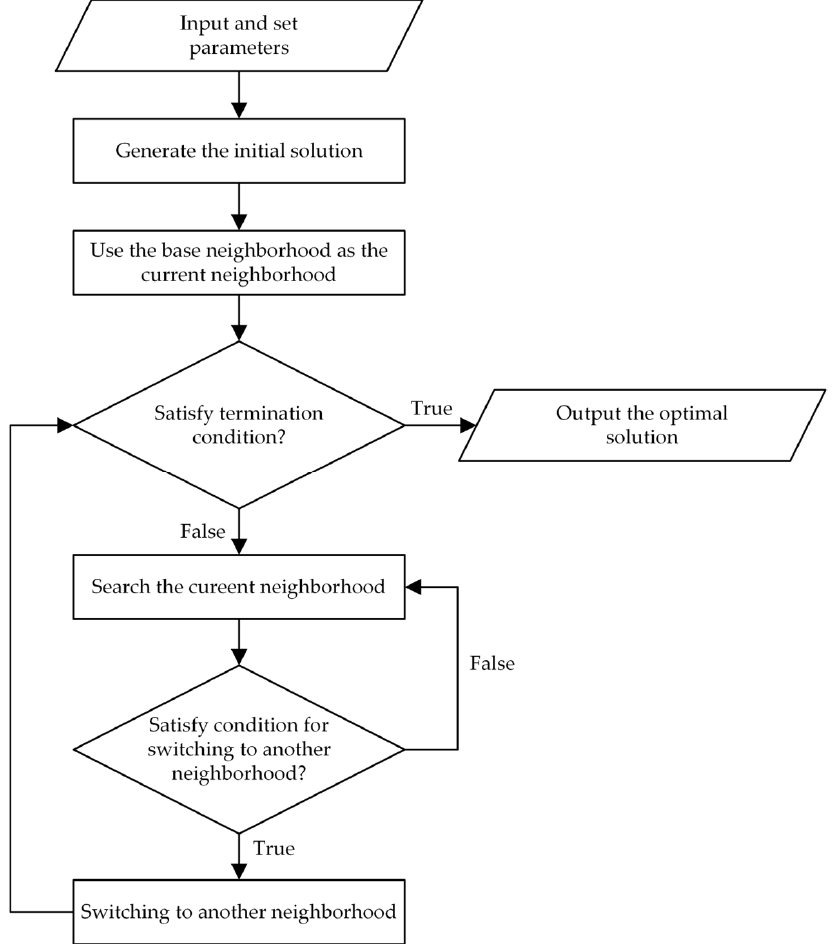
Figure 8. The flow diagram of the VNTS proposed in strip selection. Algorithm 2 Steps of variable neighborhood tabu search algorithm.